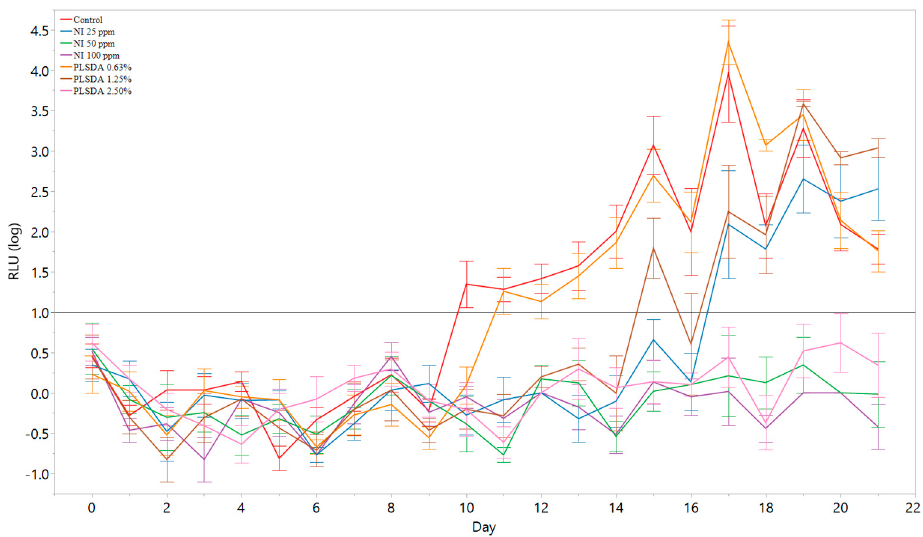
Figure 5. Using relative light units to distinguish growth/limited growth at a 1 log RLU threshold with multiple antimicrobials targeting L. monocytogenes in a miniature ham model. Plate counts at the first day with growth or at the end of 21 days are shown in Table 2.